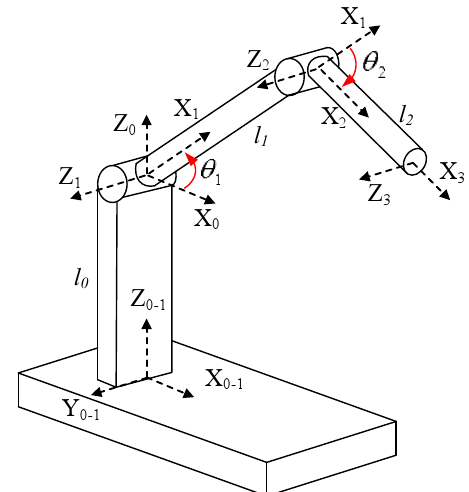
Figure 2. The architecture of the two-link robot manipulator in the electrohydraulic elastic manipulator (EEM).